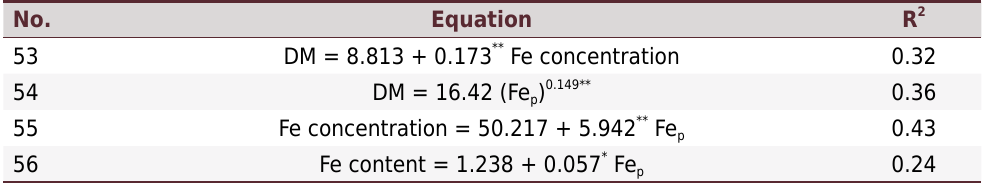
Table 7. Correlation between dry matter in the shoots (DM), concentration and content of Fe in the plant, and concentration of Fe-pyrophosphate (Fe p ) and of clay